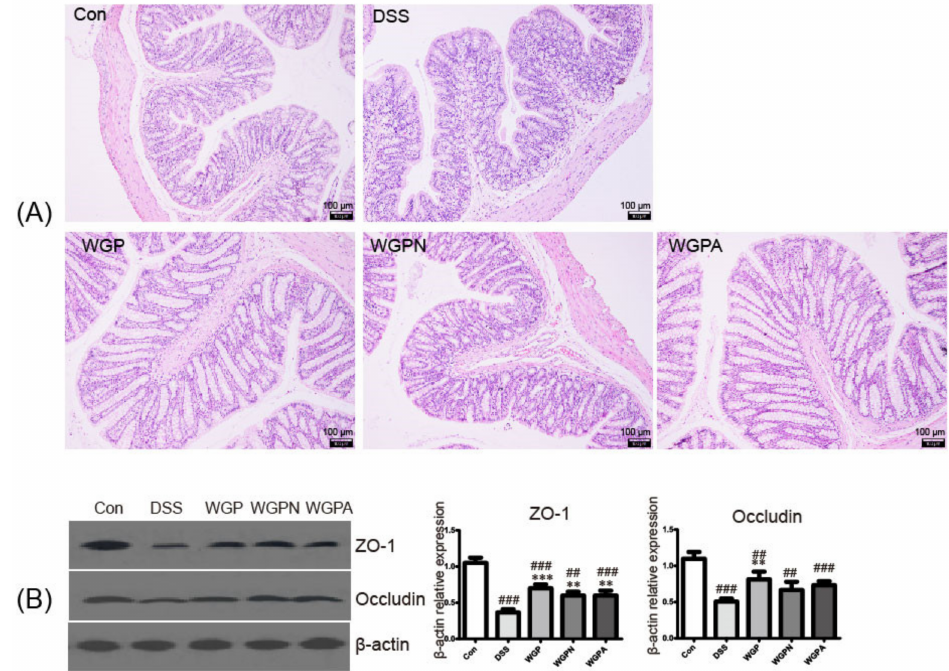
Figure 2. Changes of the colon structure and intestinal barrier: ( A ) histopathological observa- tion; ( B ) intestinal barrier-related protein expression by Western blotting. The bars represent the mean ± SD, n = 3; ## p < 0.01, ### p < 0.001 compared with the con group; ** p < 0.01, *** p < 0.001 compared with the DSS group. Con, control group; DSS, colitis group; WGP, WGP treatment group; WGPN, WGPN treatment group; WGPA, WGPA treatment